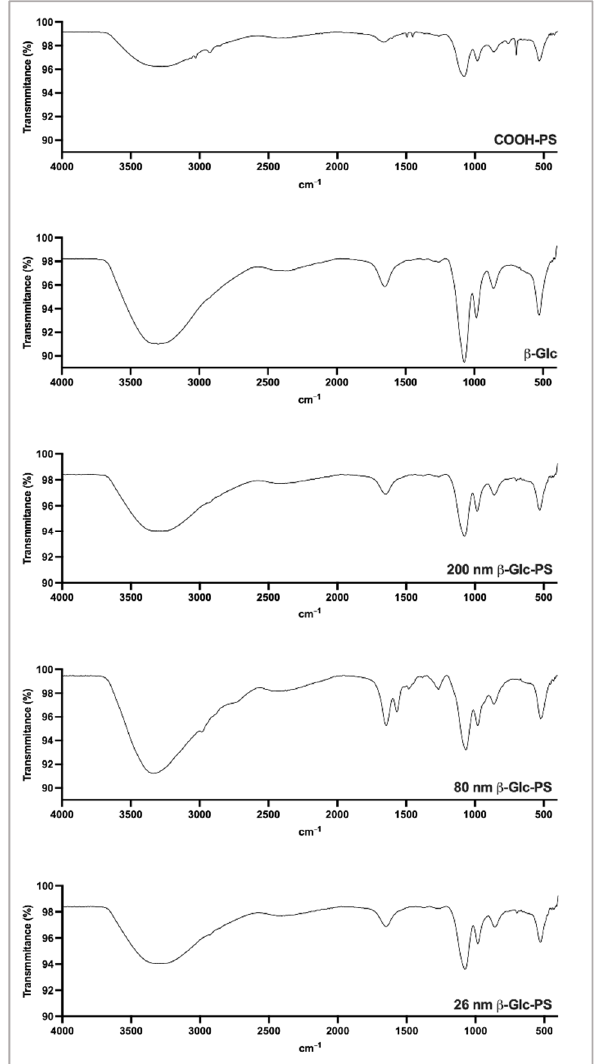
Figure 3. Fourier transformed infrared (FTIR) spectra of COOH-PS, soluble β -Glc and β -Glc-PS NP. Sample suspensions were scanned using PerkinElmer Frontier FTIR (Universal ATR Sampling Assessory) with a resolution of 4 cm − 1 in ATR sampling mode. Each condition was set in triplicate.